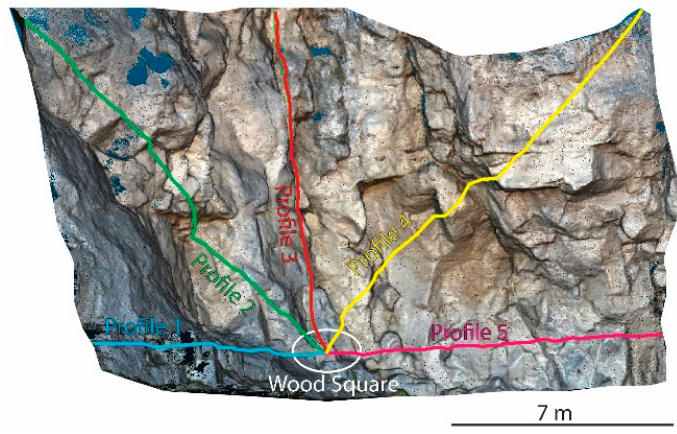
Figure 8. Profiles 1–5 traced on the DP and LS models.